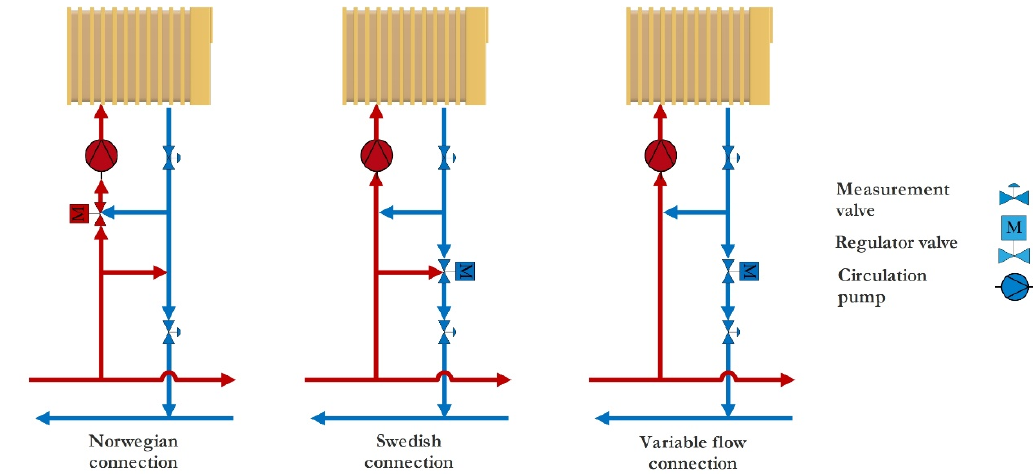
Figure 2. Schematic view of the Norwegian, Swedish, and variable flow hydronic connections used in the studied hydronic system, including measurement and regulator valves and a circulation pump.